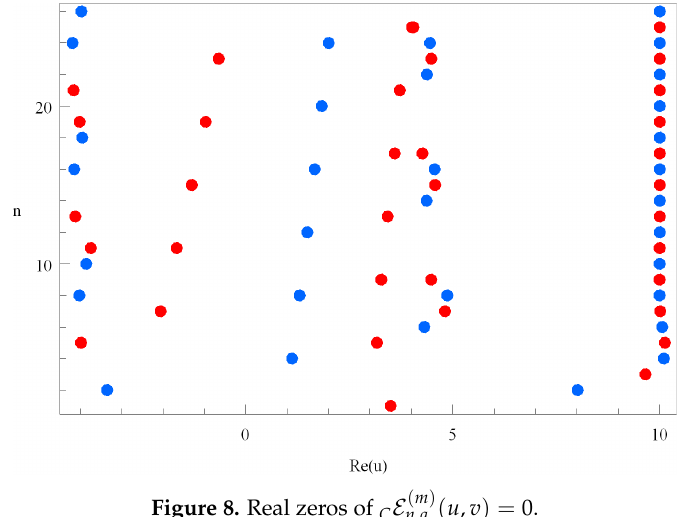
Figure 8. Real zeros of C E